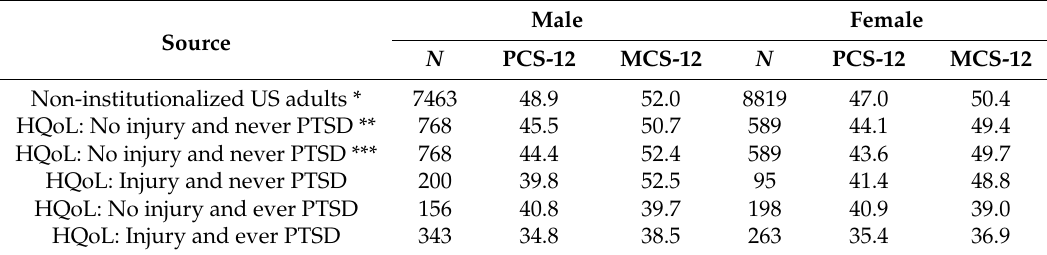
Table 1. Mean PCS-12 and MCS-12 for the US population and mean PCS-12 and MCS-12 for selected HQoL groups by